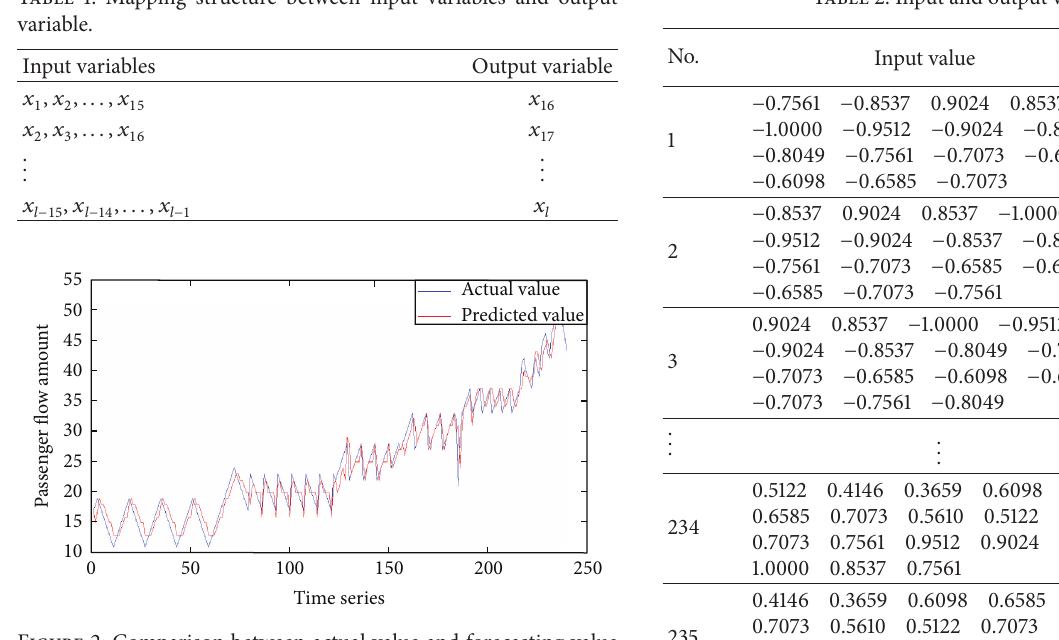
Figure 2: Comparison between actual value and forecasting value based on RBF NN.